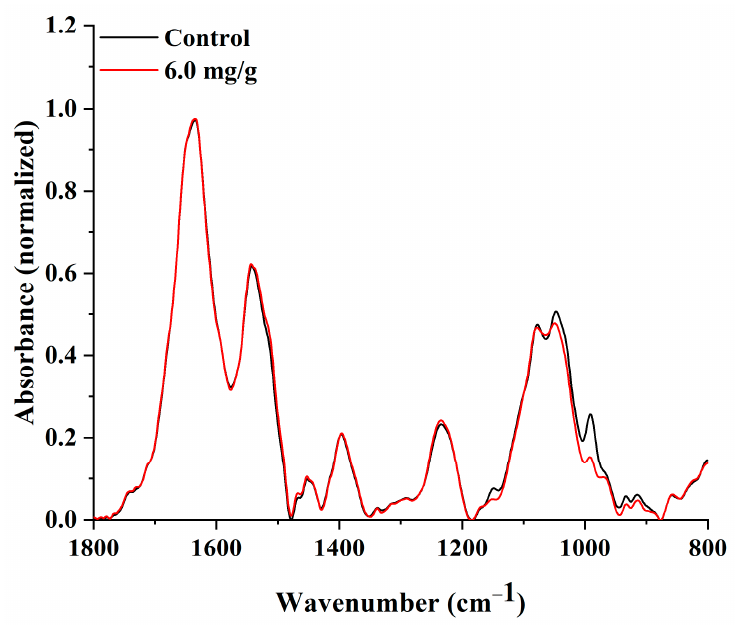
Figure 10. The ATR–FTIR spectra of biofilm of P. aeruginosa PAO ‐ 1 formed of BC membranes with immobilised AlgL (6.0 mg/g of dry BC) and native BC as a control.